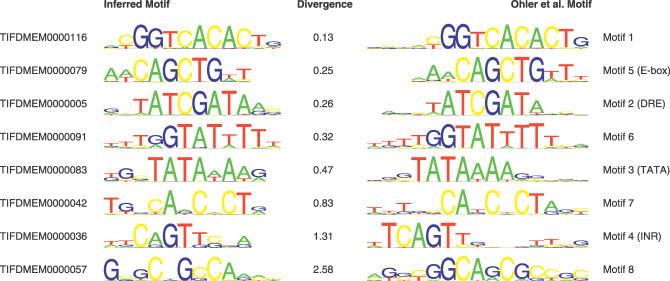
Best Reciprocal Matches between the NestedMICA Promoter Motif Set (Left) and the Ten Core Promoter Motifs Reported by Ohler et al. (2002) (Right)Scores in the central column represent divergence scores (see Materials and Methods). All matches were found to be highly significant (p < 0.001 using the shuffling test described under Materials and Methods).